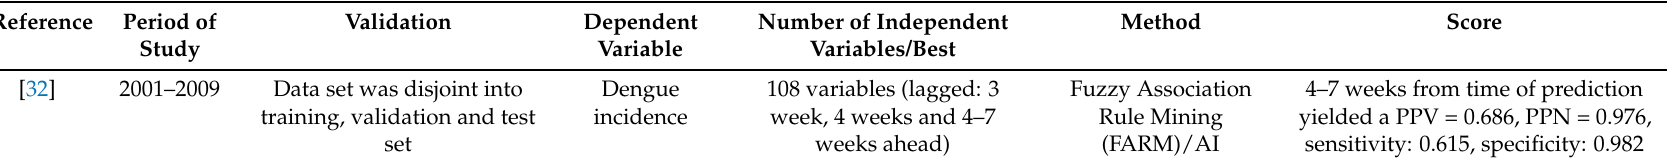
Table A2. Summary table of dengue predictive studies included in review AI: Artificial Intelligence, SM: Statistical